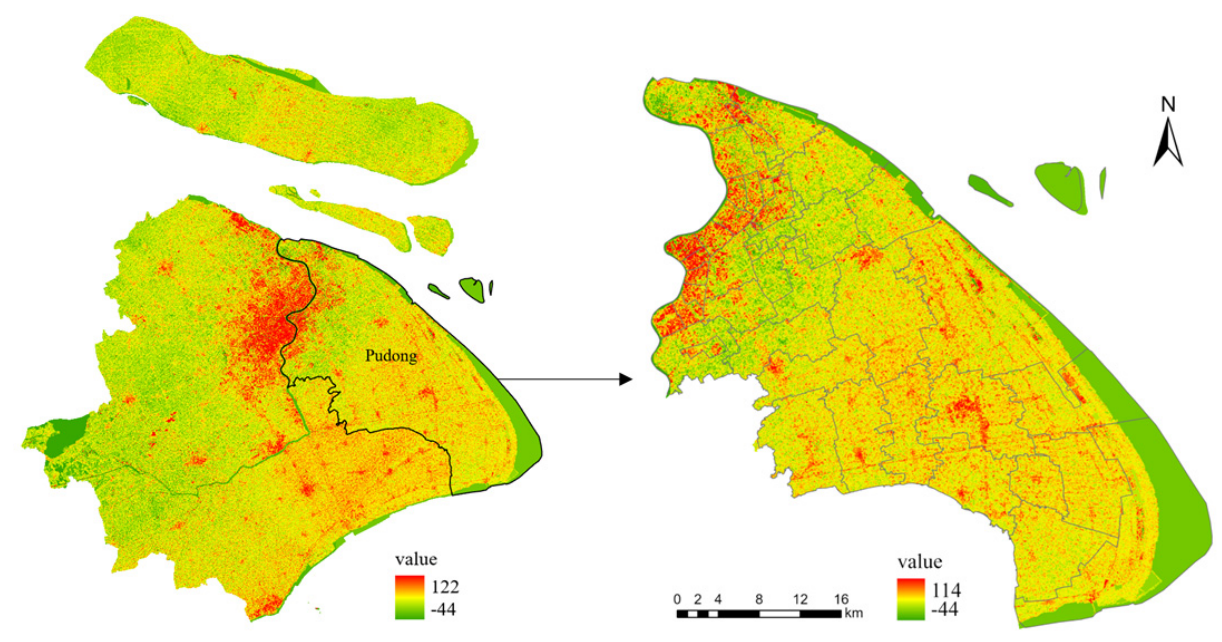
Figure 3. DEM map of the 12.5-m elevation in Pudong New Area.